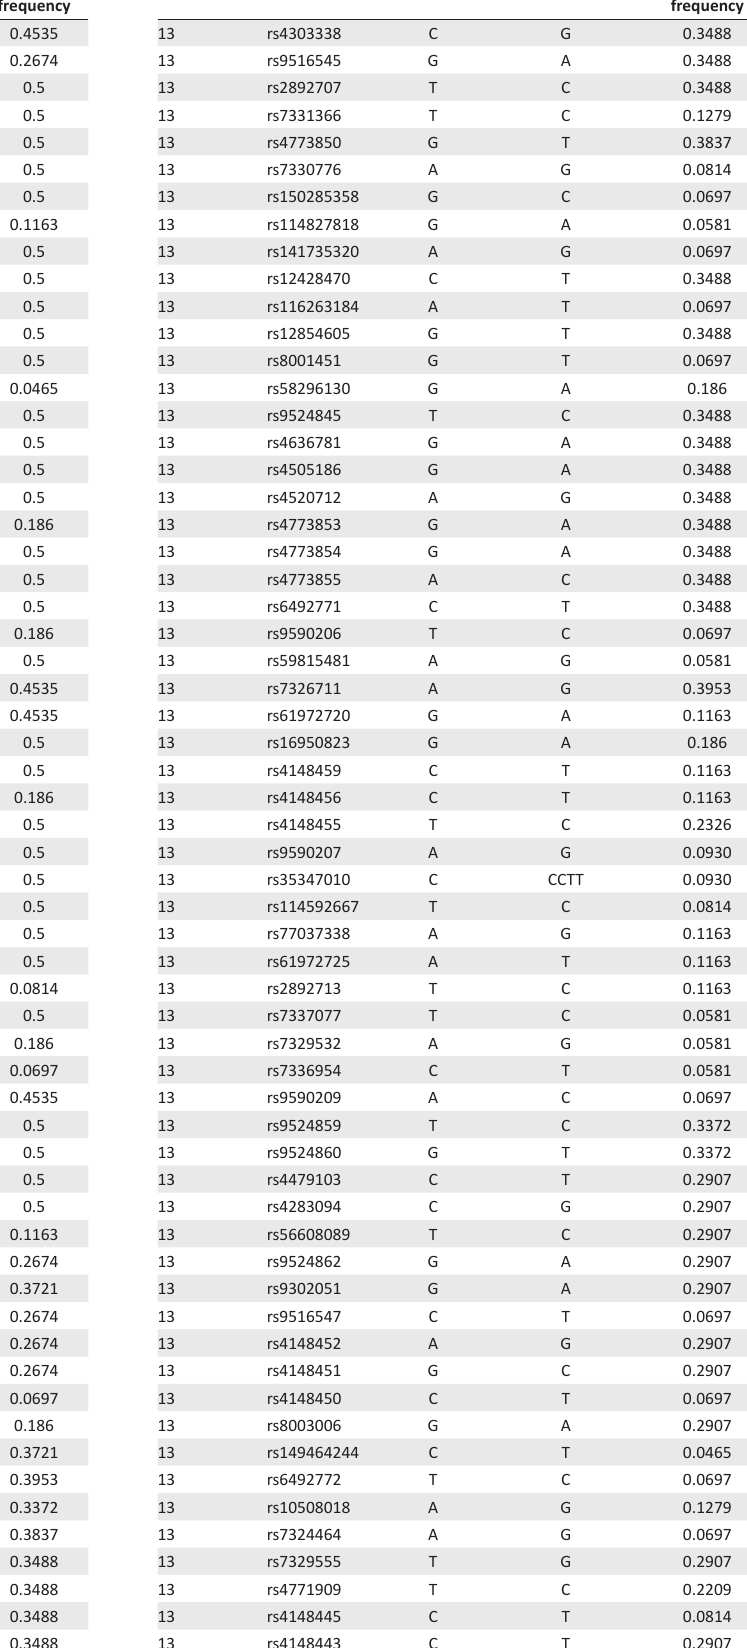
Table 1-A1 (Continues...): Minor allele frequencies for 1846 polymorphisms in 43 black South Africans. Chromosome Polymorphism Minor allele